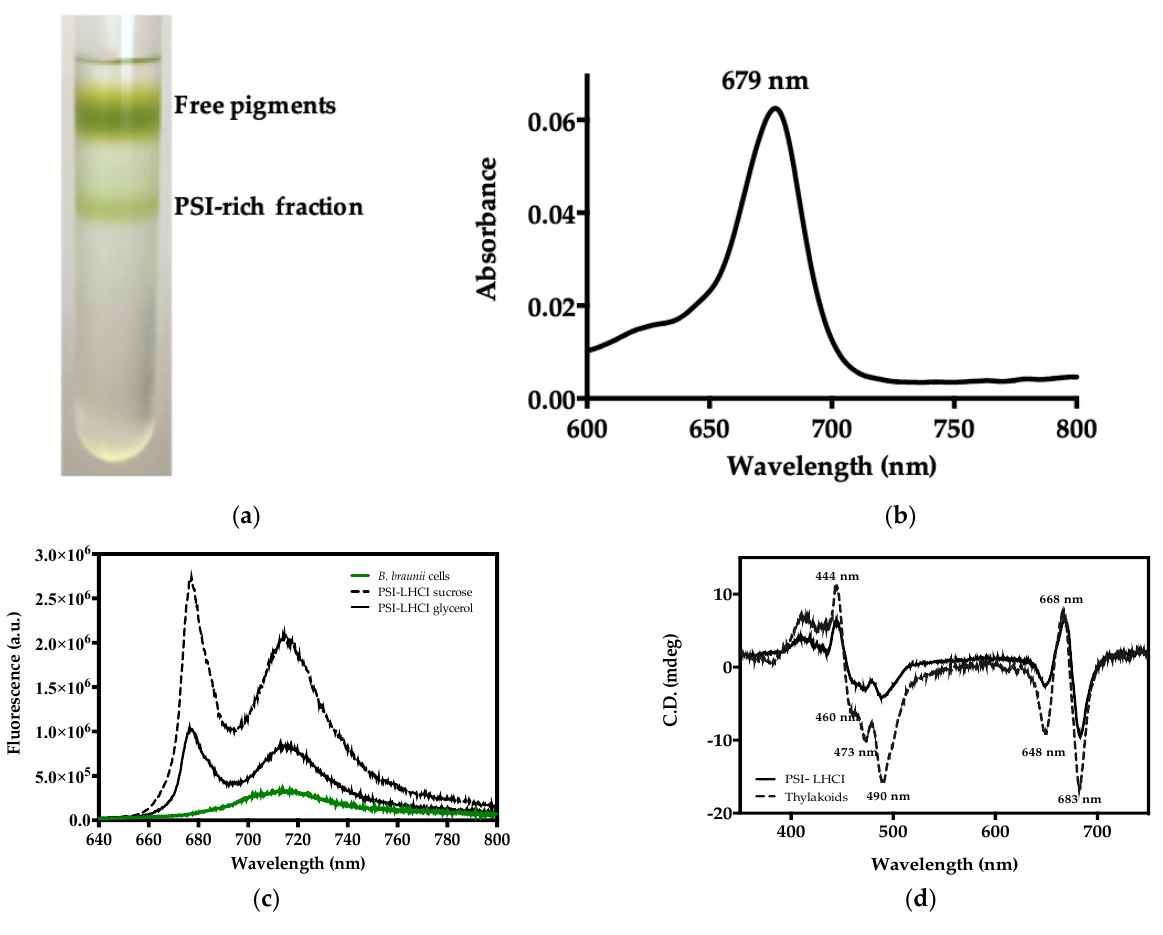
Figure 1. Purification and characterization of PSI-LHCI of B. braunii . ( a ) Sucrose gradient separation of B. braunii STM. The upper band consists of free pigments and unbound proteins, and the lower green band corresponds to the PSI-rich fraction; ( b ) room temperature absorption spectrum of the PSI-LHCI complex sucrose gradient fraction; ( c ) 77 K fluorescence emission spectra of the PSI-LHCI sucrose gradient fraction (PSI-LHCI sucrose) and the 5 – 30% glycerol gradient fraction (PSI-LHCI glycerol), and B. braunii cells, excitation wavelength 436 nm; ( d ) visible CD spectra of purified PSI- LHCI complex and thylakoid membranes measured in a 10 mm quartz cuvette, at a scanning speed of 50 nm/min, a bandwidth of 1 nm, and 25 °C. Sample concentration was adjusted to 0.4 mg/mL Chl and the spectra normalized at the maximum in the Qy region.